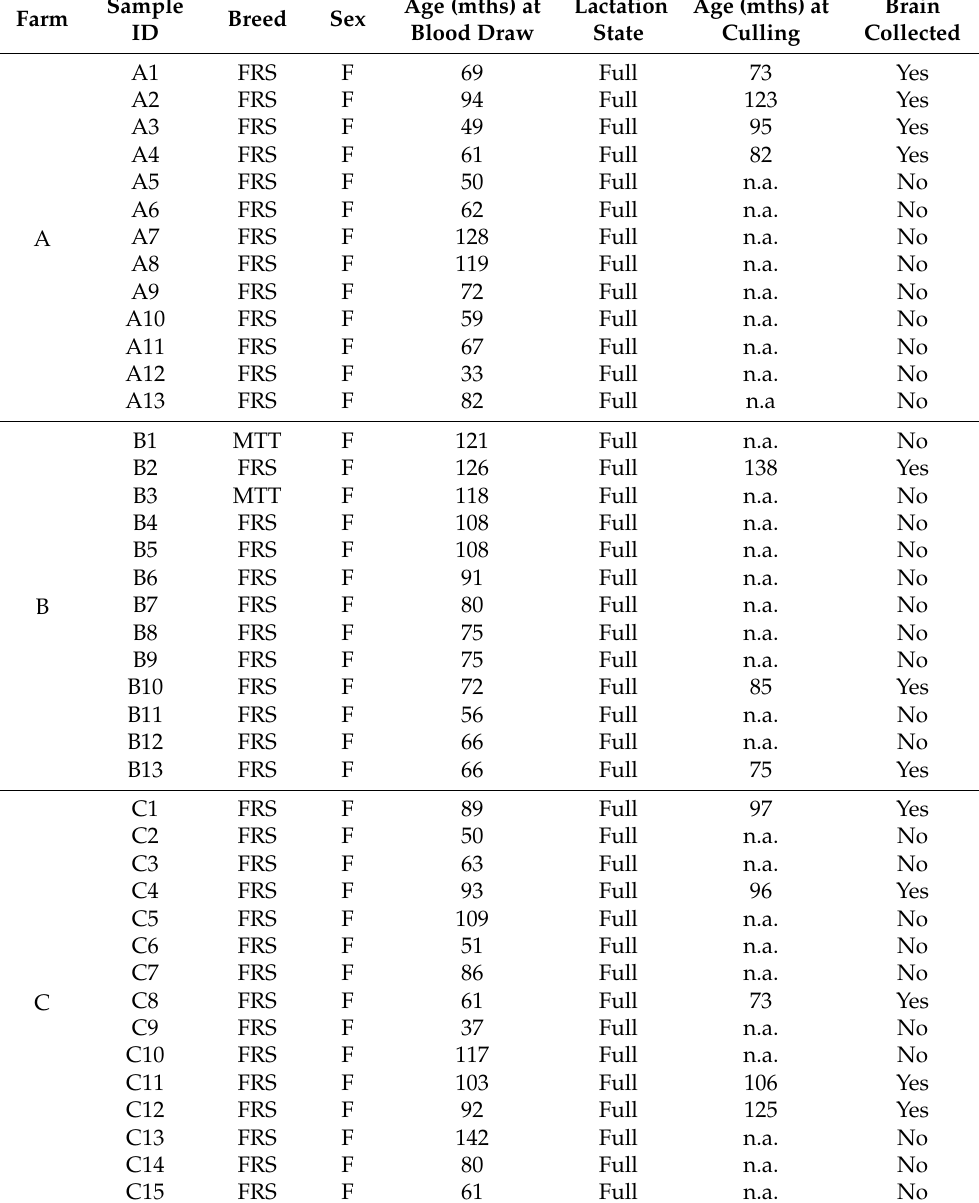
Table 1. General data of the dairy